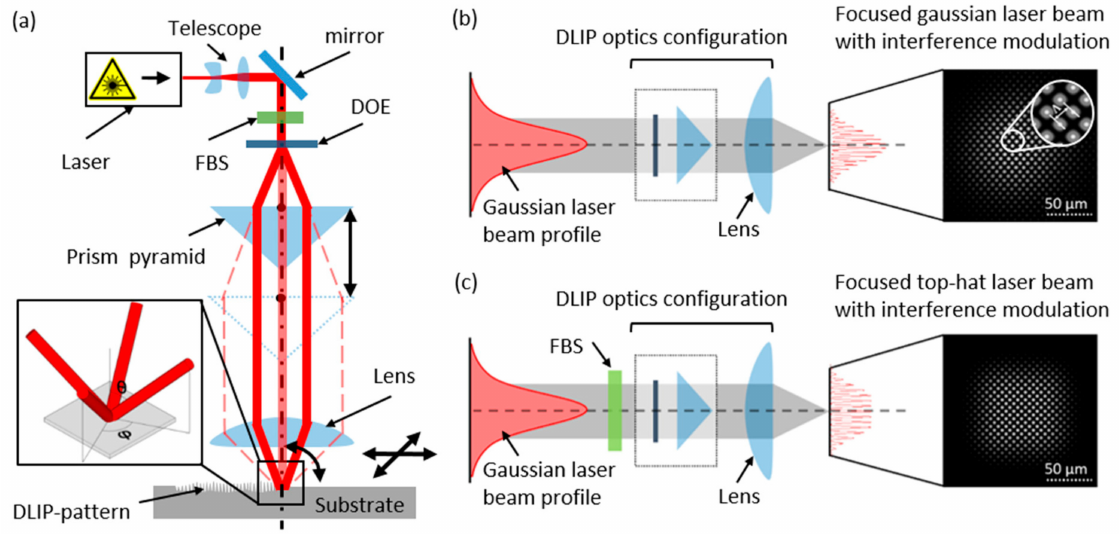
Figure 2. ( a ) Schematic representation of the experimental setup for structuring dot-like pattern using a DOE-based DLIP optical configuration combined with an FBS element; the inset at the sample surface shows the sketch of four symmetrically distributed interfering sub-beams. The incidence angle θ is the same for all four beams. The azimuthal angle φ between each consecutive beam is √ 90 ◦ and the spatial period can be calculated by Λ 4 = λ / ( 2 · sin θ ) , where λ is a laser wavelength. Representation and measurement of the interference pattern distribution (with a beam profiling camera) for the setup without ( b ) and with ( c ) the FBS